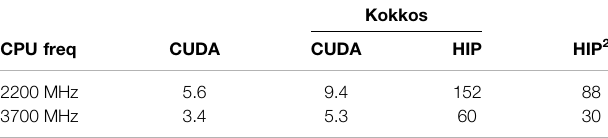
TABLE 6 | Kernel launch latencies in microseconds as a function of CPU clock frequency, measured by timing the execution of 10,000 empty